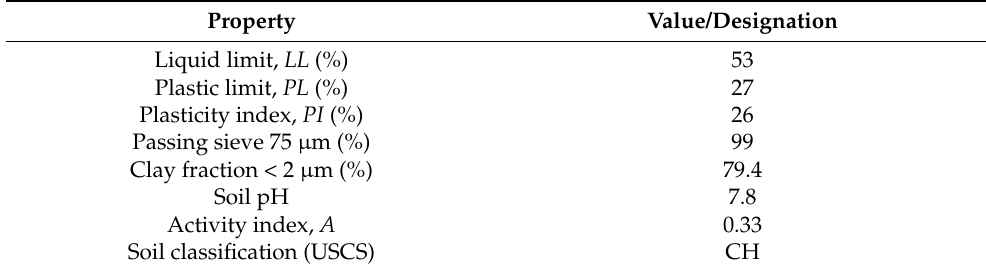
Table 1. Characteristics and classification of kaolin clay used.